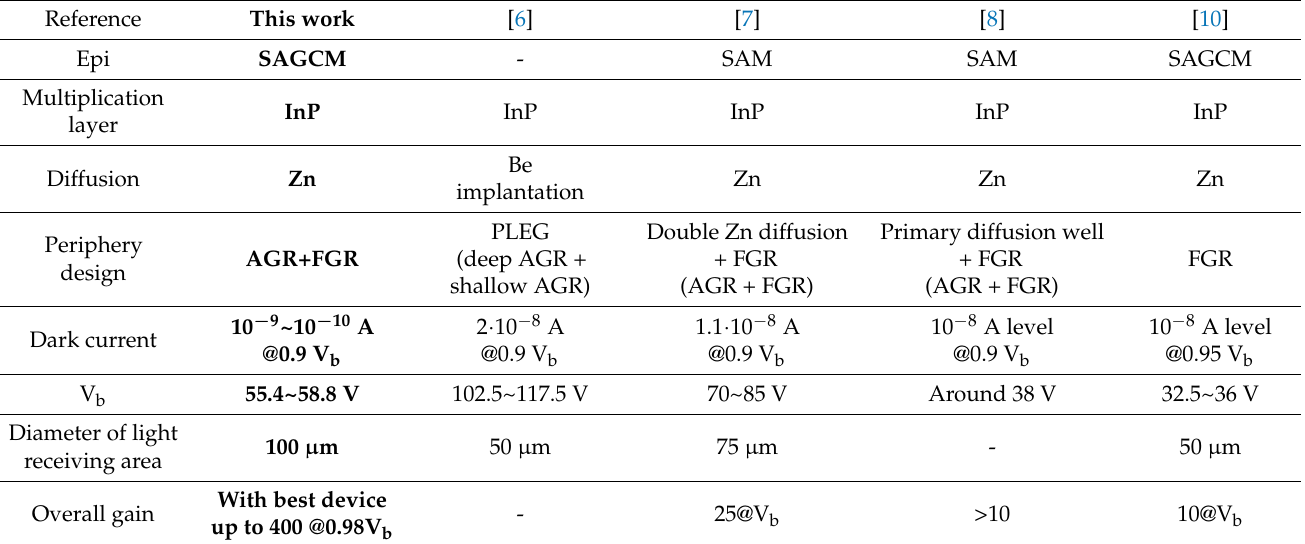
Table 2. Comparison of our photodiode with those in the